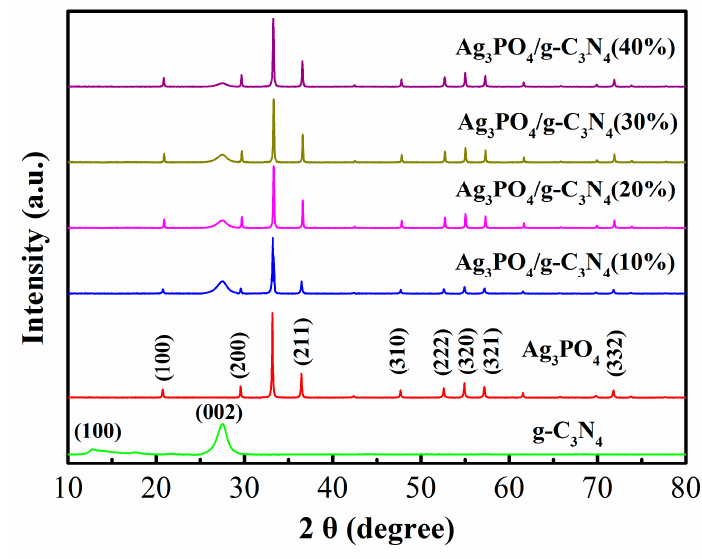
Figure 1. X ‐ ray diffraction patterns of g ‐ C 3 N 4 , Ag 3 PO 4 , and Ag 3 PO 4 /g ‐ C 3 N 4 (X) composites. Figure 1. X-ray diffraction patterns of g-C 3 N 4 , Ag 3 PO 4 , and Ag 3 PO 4 /g-C 3 N 4 (X)